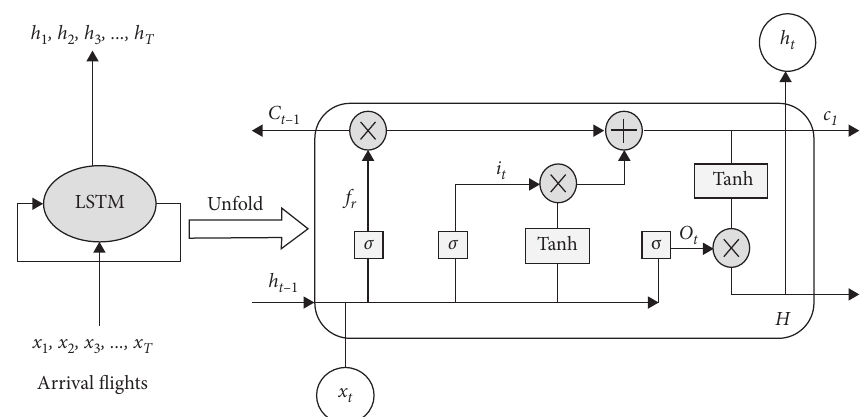
Figure 3: The internal structure of an LSTM